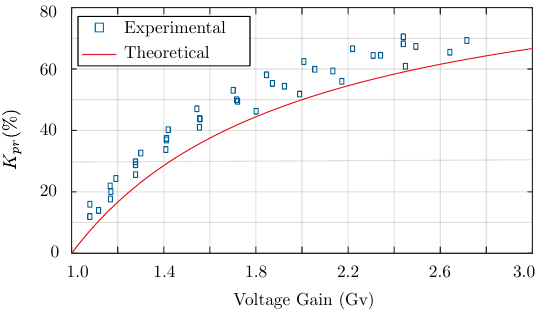
Figure 9. Experimental partial power ratio for the Step-Up Flyback based